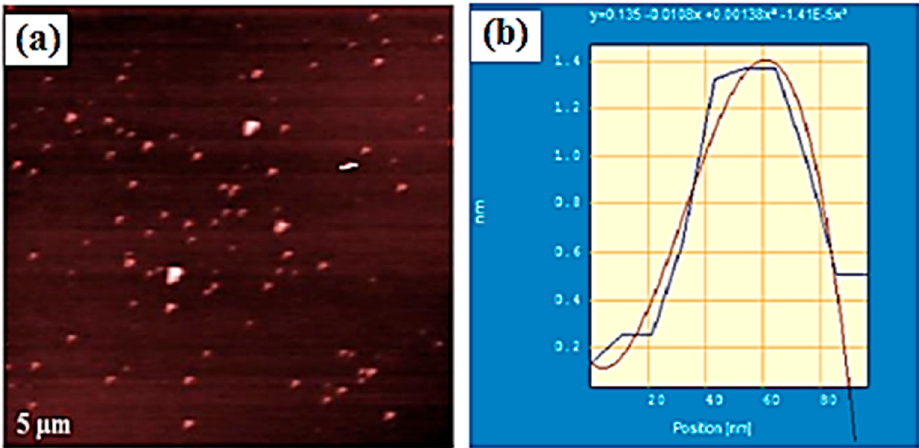
Figure 8. Morphology of graphene nanoparticles: ( a ) AFM image of f-rGONPs; ( b ) Height profile of f-rGONPs. Reproduced with permission [59].